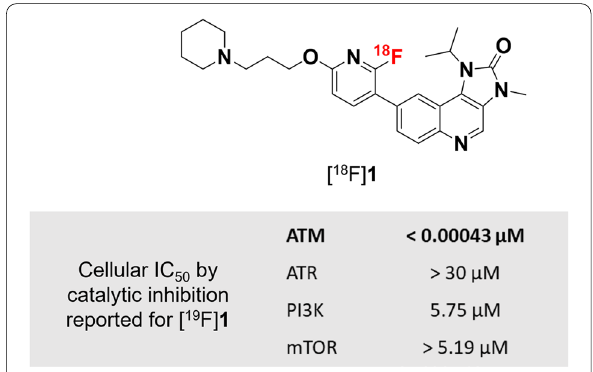
Fig. 1 Target compound [ 18 F] 1 and reported inhibitory data